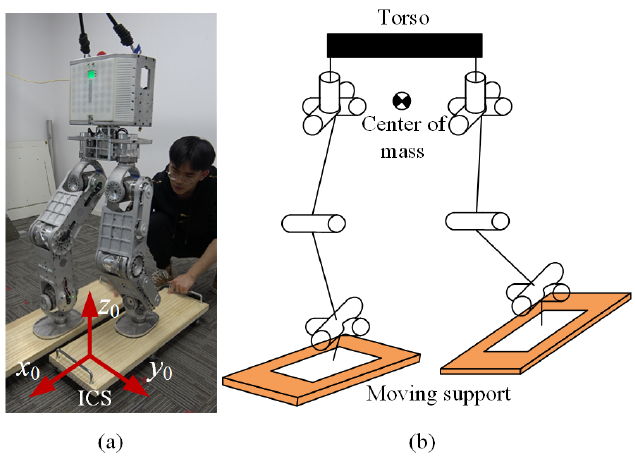
Figure 1. Walker3 humanoid robot with 12 actuated DoFs ( a ) and its kinematic model ( b ).